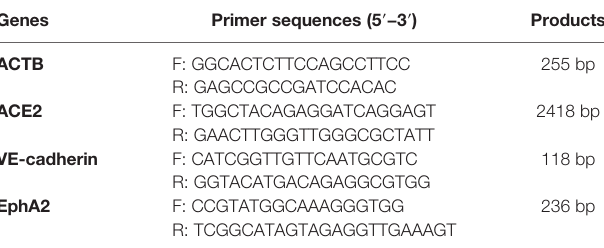
TABLE 1 | The primer sequences of genes used in